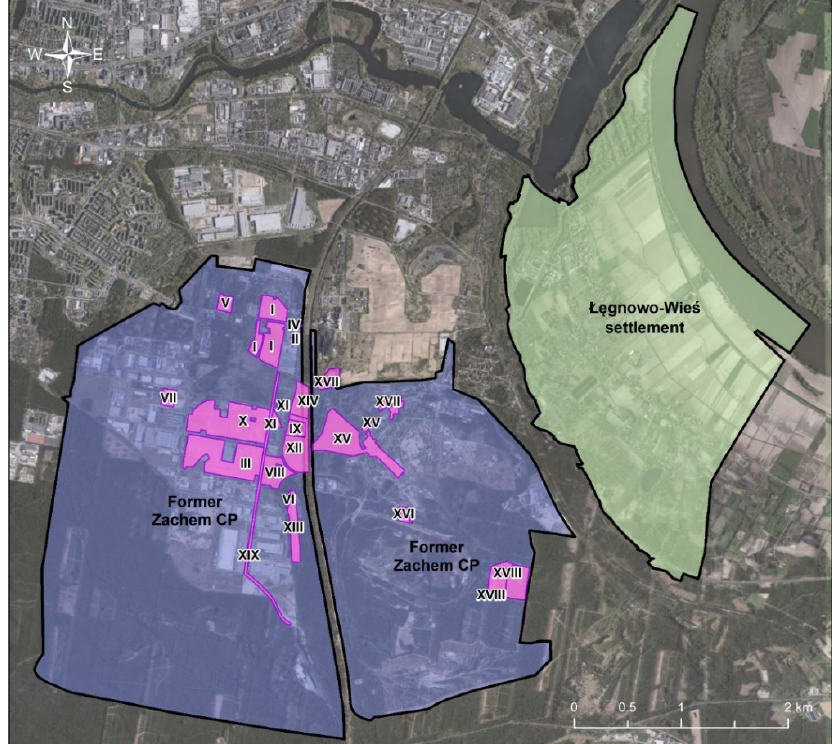
Figure 2. Location of the main contamination sources in the former Zachem CP area by BRDEP,